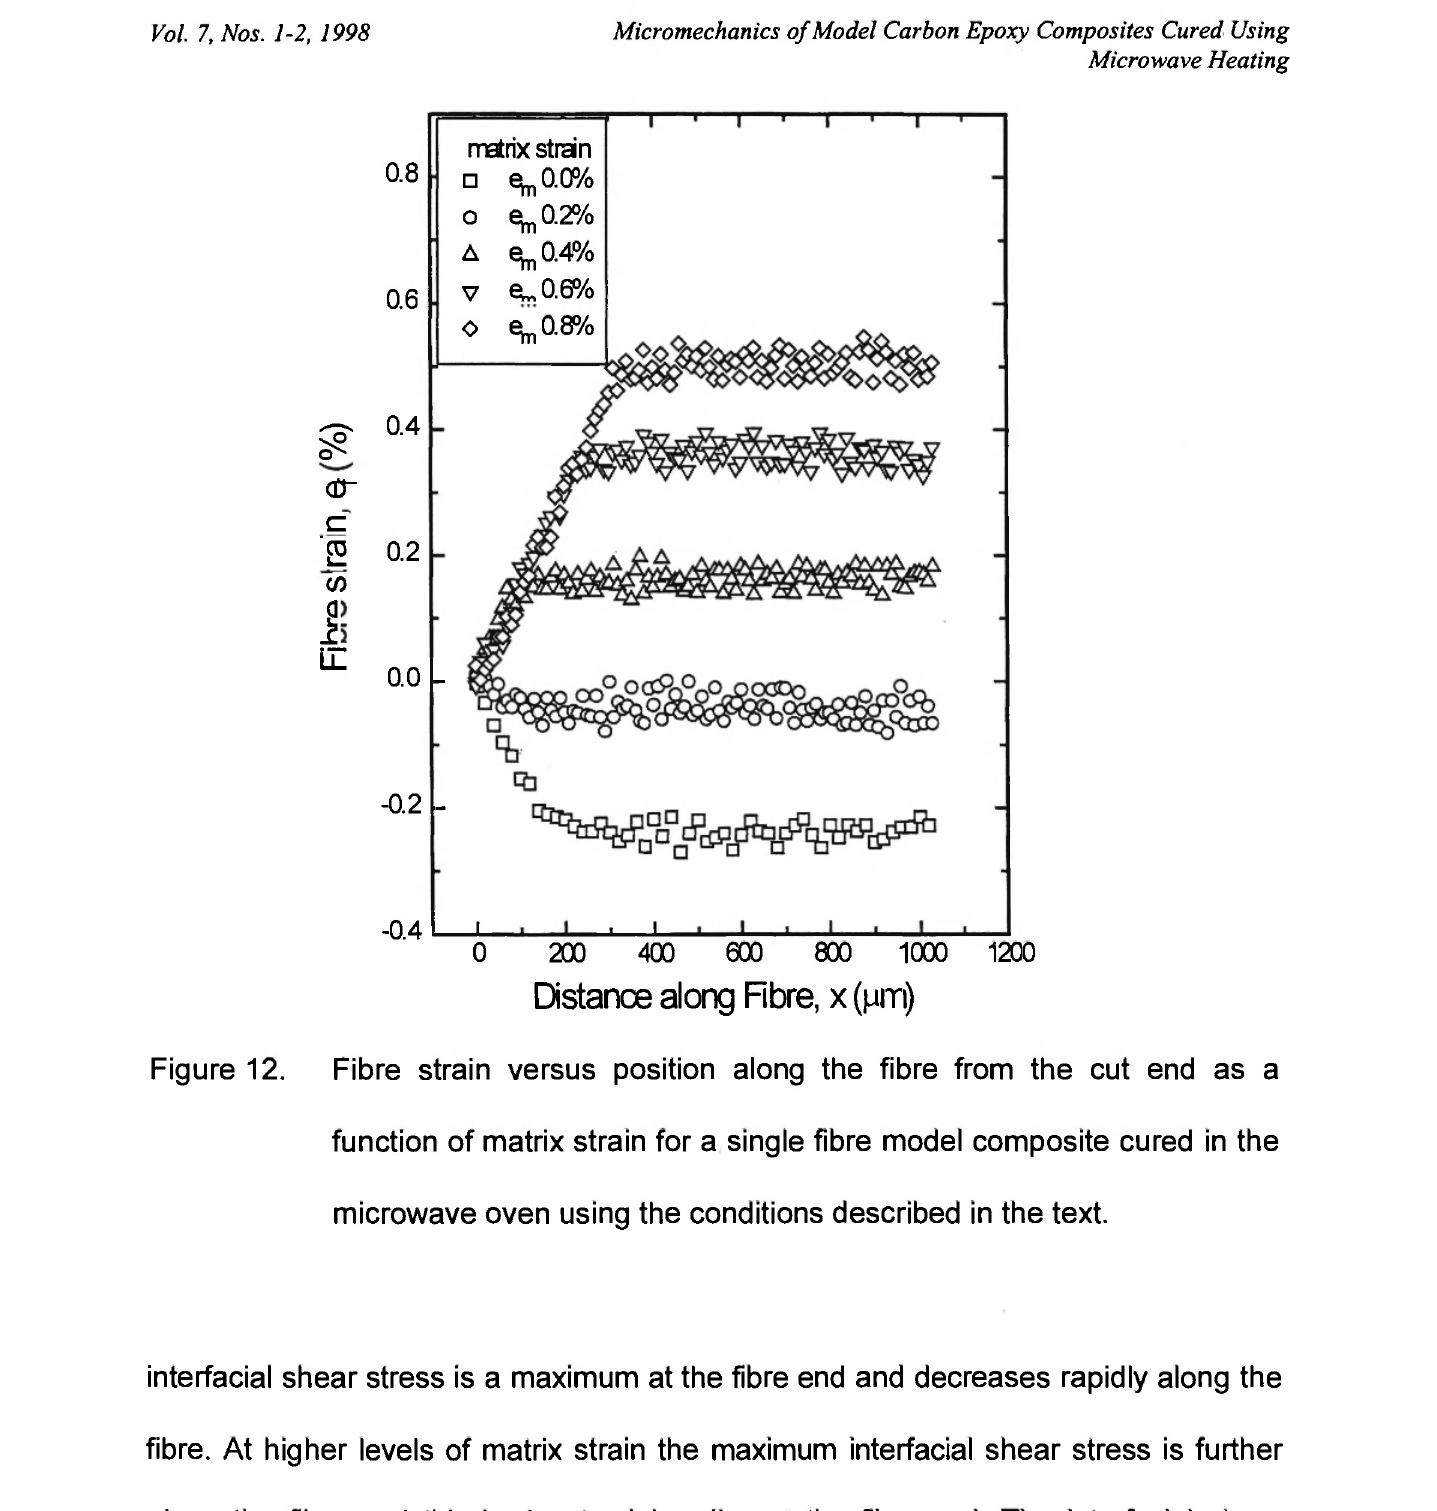
Figure 12. Fibre strain versus position along the fibre from the cut end as a function of matrix strain for a single fibre model composite cured in the microwave oven using the conditions described in the